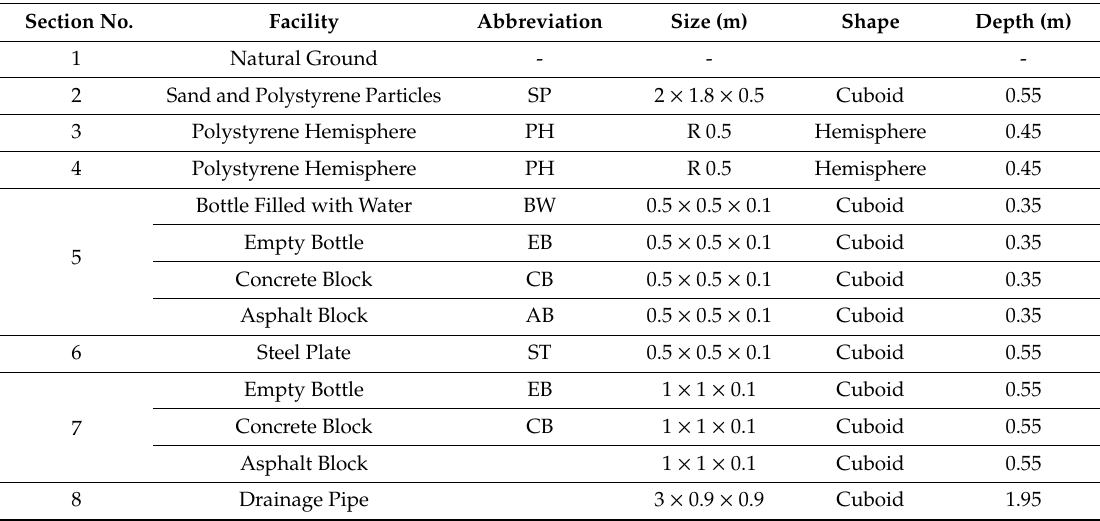
Table 1. Facilities installed in the ground of the